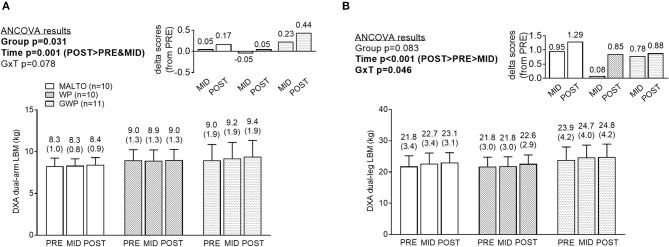
Segmental DXA data differences between supplementation groups. Significant time effects were observed for DXA dual-arm LBM (A) and DXA dual-leg LBM (B), with MID, and/or POST values being greater than PRE. While a significant group × time interaction was observed for DXA dual-leg LBM, no significant between-group differences at each time point were observed. All data are presented as means ± standard deviation values, and values are indicated above each bar. Additionally, each data panel has delta values from PRE included as inset data. MALTO, maltodextrin group; WP, standardized whey protein group; GWP, graded whey protein group.